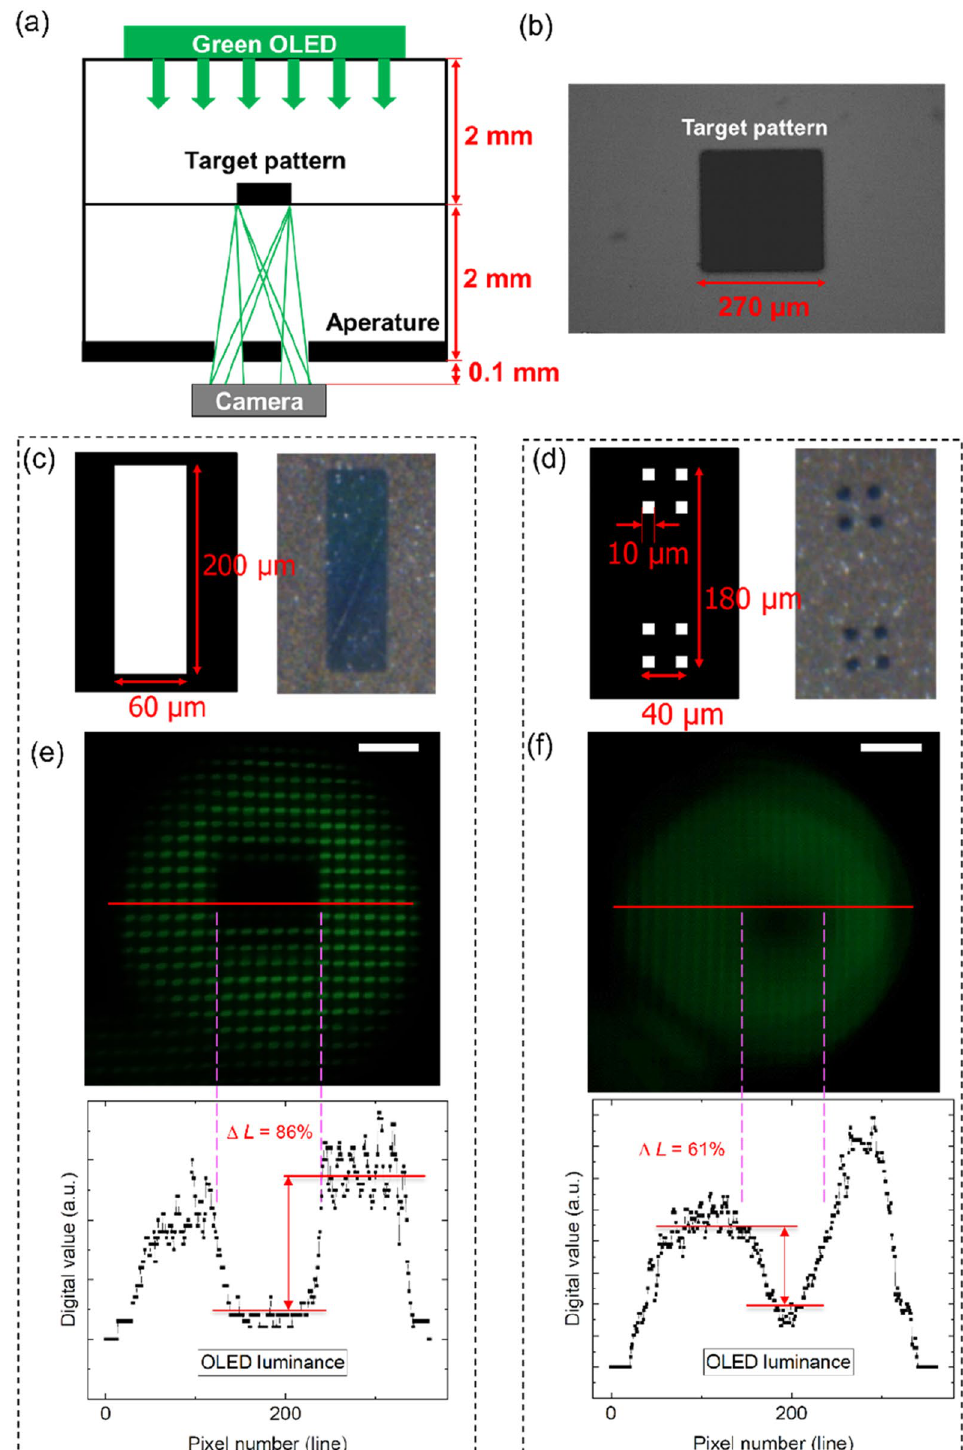
Figure 2. ( a ) Micro-sized aperture photomask structure with green light from a commercial OLED smartphone. ( b ) Actual target shape with a 270 µm square pattern. ( c ) 60 µm × 200 µm micro-sized aperture and actual pattern with optical microscope. ( d ) Eight 10 µm × 10 µm micro-sized apertures and actual pattern with optical microscope. ( e ) Captured image with 60 µm × 200 µm micro-sized aperture, scale bar: 200 µm and digital cross-sectional line luminance value of the captured image. ( f ) Captured image with a total of eight 10 µm × 10 µm apertures, scale bar: 200 µm and digital cross-sectional line luminance